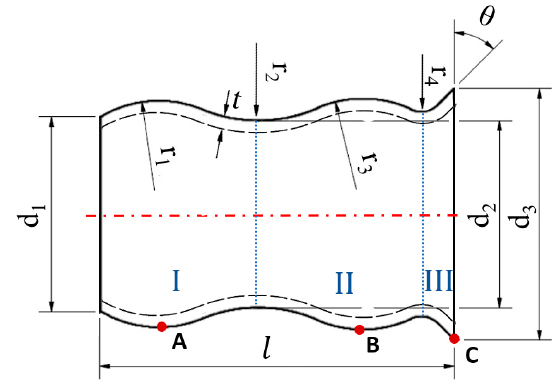
Figure 1. Geometrical configuration of an irregular bellows.